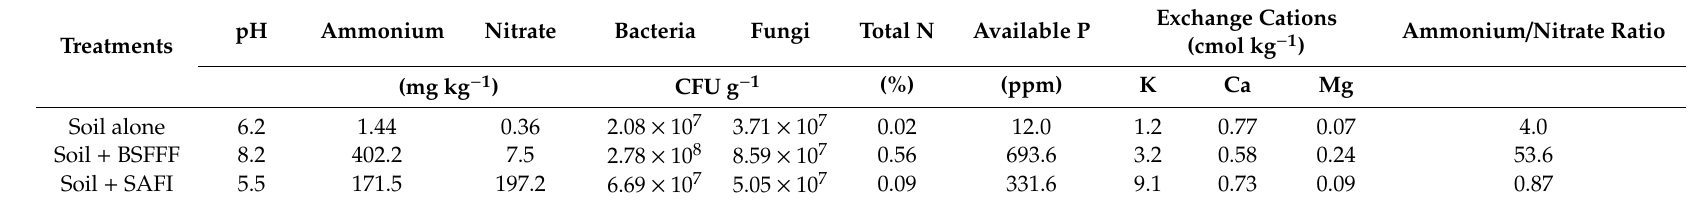
Table 2. Properties of soil alone and amended soil at the start of the long rain season experiments.